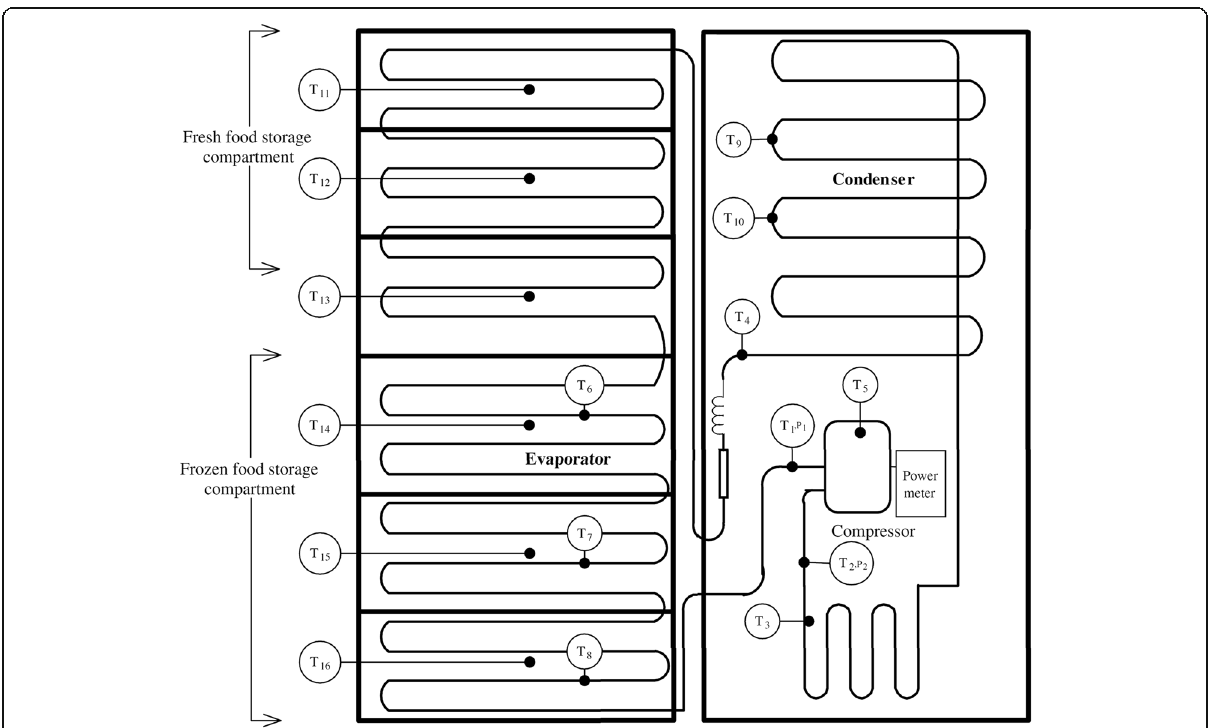
Fig. 7 Schematic diagram of a domestic refrigerator with HFC134a, mineral oil and TiO 2 nanoparticles [96]. Reproduced with permission from